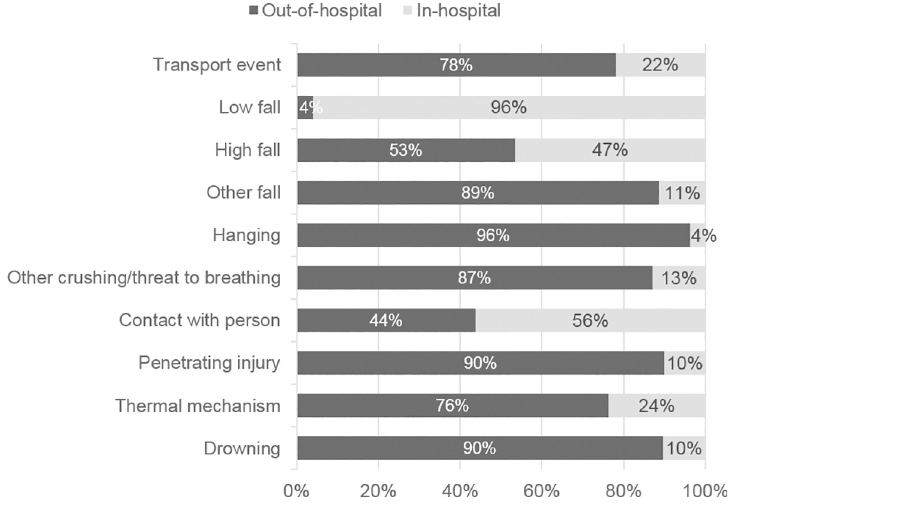
Fig 1. Proportional differences in out-of-hospital and in-hospital deaths by cause of